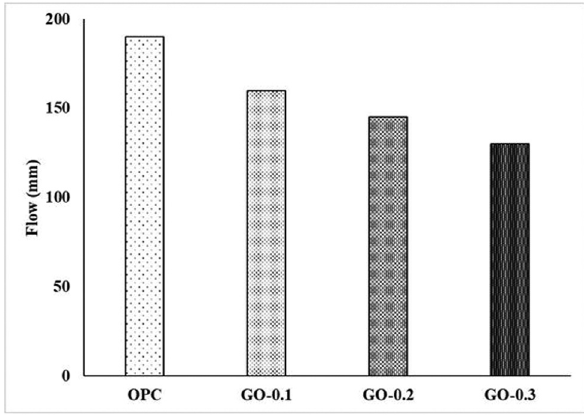
Figure 4: Flow test values of all